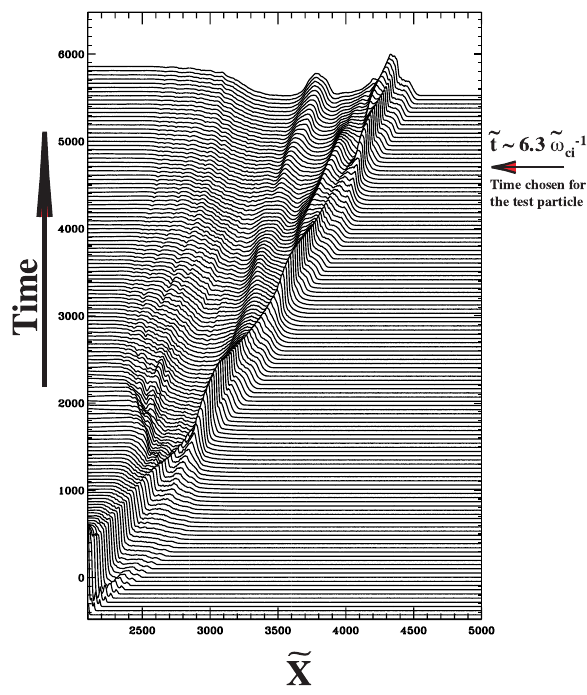
Fig. 1. Time evolution of the magnetic moment ratio µ/µ us for the same selected particles of Fig. 3 (panels g, h, i) in absence of the electrostatic field component ( e E lx = 0). In order to emphasize the differences with Fig. 3, the same color code for the curves (black, red and blue) is used.